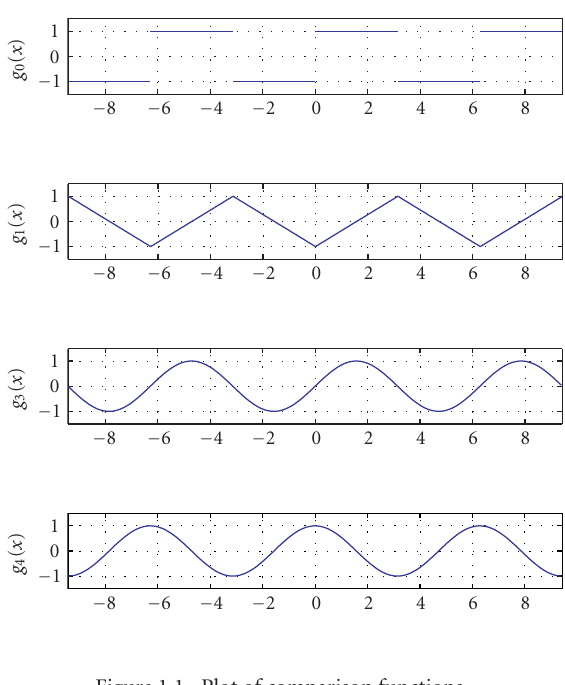
Figure 1.1. Plot of comparison